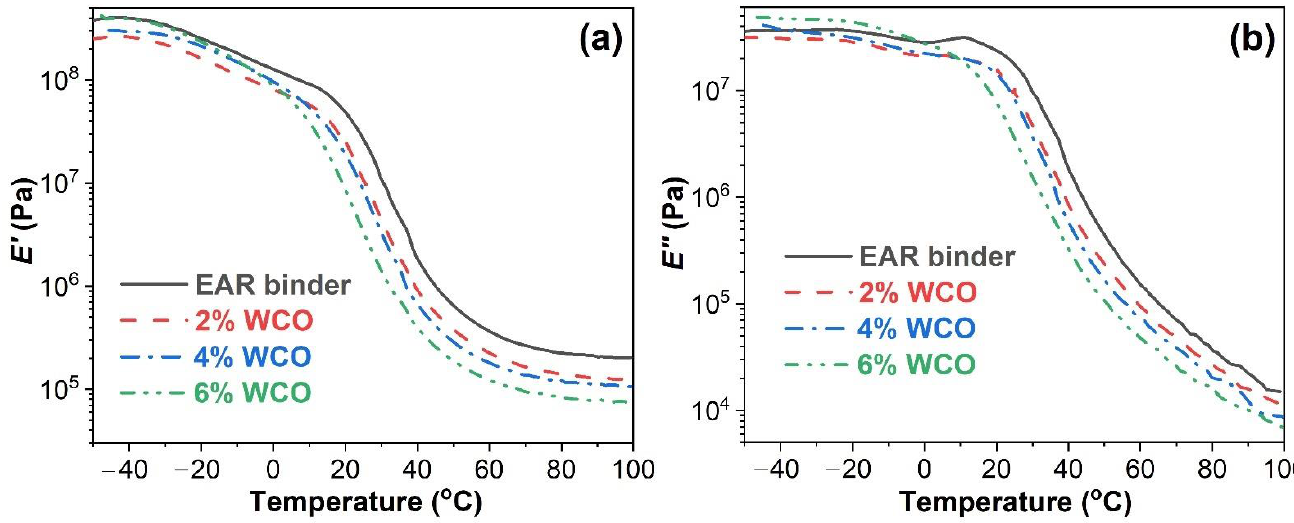
Figure 3. ( a ) E′ and ( b ) E″ vs. temperature of the unmodified and WCO-modified EAR binders. Figure 3. ( a ) E (cid:48) and ( b ) E” vs. temperature of the unmodified and WCO-modified EAR